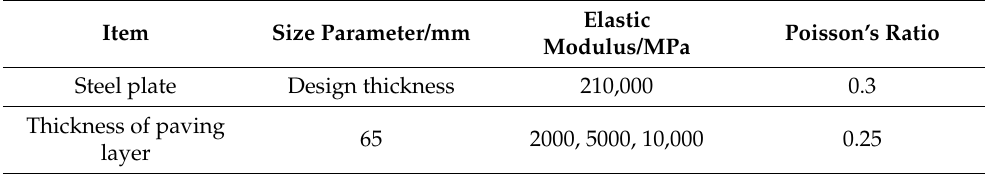
Table 1. Numerical model parameters of bridge deck pavement.